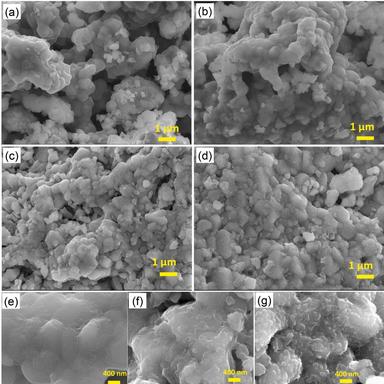
SEM images of (a) NCM, (b) Si-0, (c) Si-20 % and (d) Si-50 %; zoomed SEM images of (e) Si-20 %, (f) Si-20 % and (g) Si-50 %.